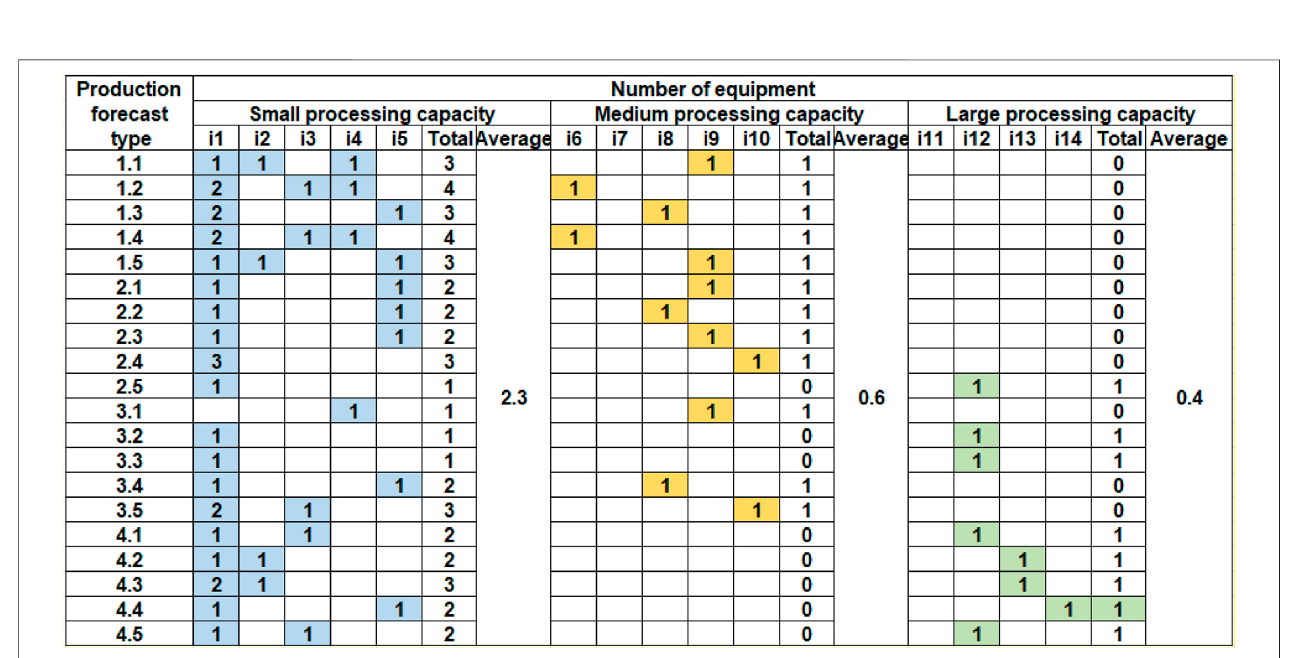
FIGURE 9 | Optimal serialization of modular equipment.